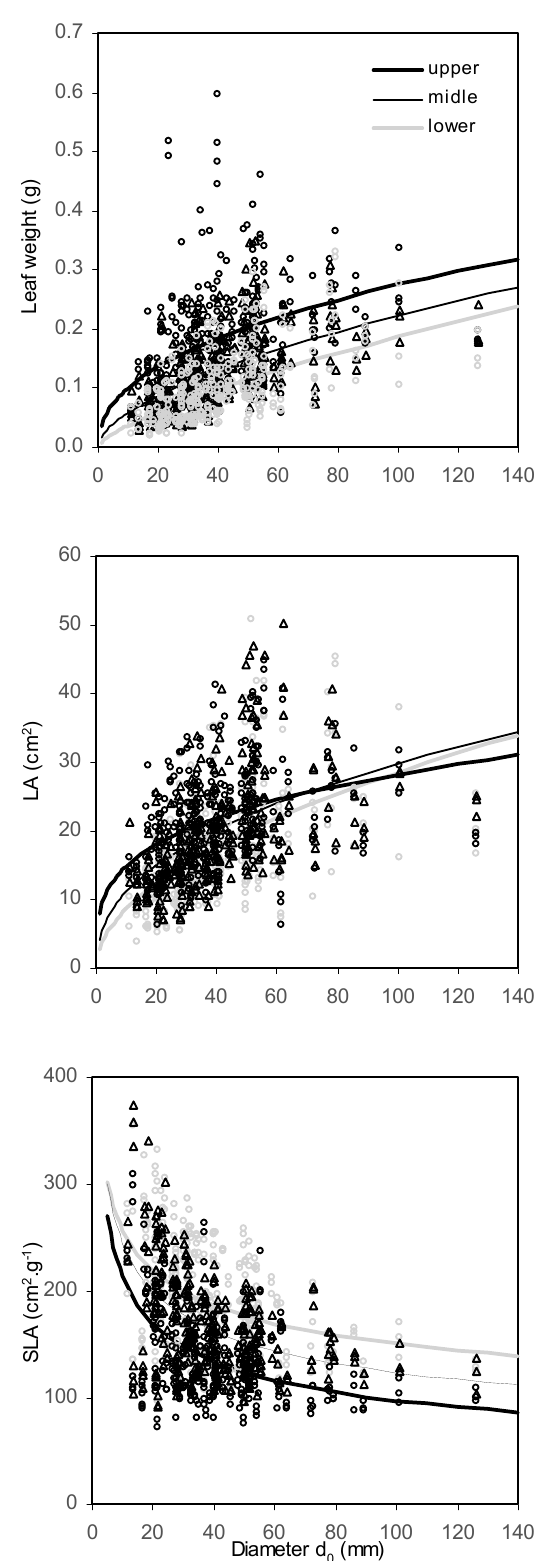
Figure 3. Relationship between d 0 stem base diameter and individual leaf mass (upper plate), leaf area (middle plate), or specific leaf area (lower plate) in the sampled common aspen trees with respect to foliage position along the tree crown.